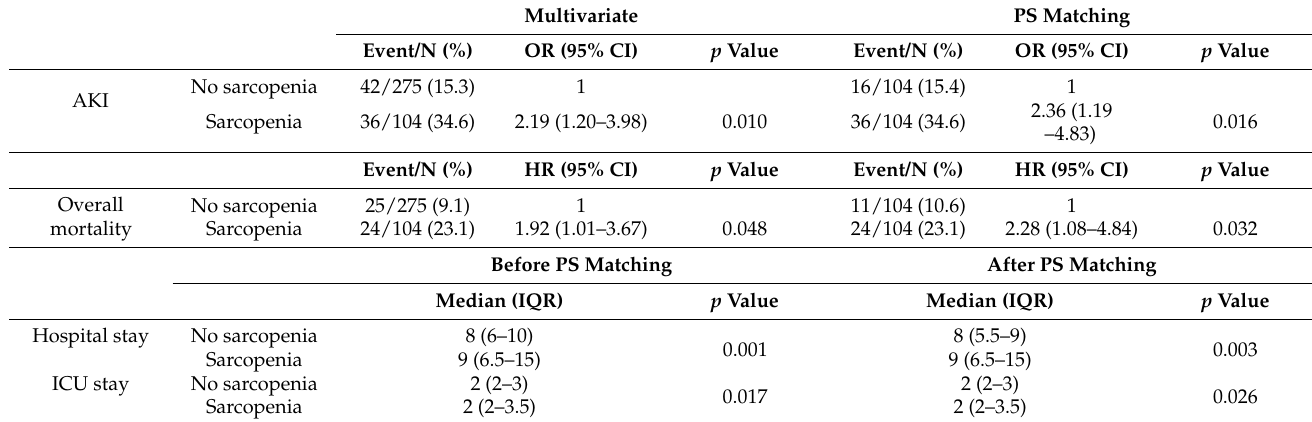
Table 4. Clinical outcomes adjusted by sarcopenia.